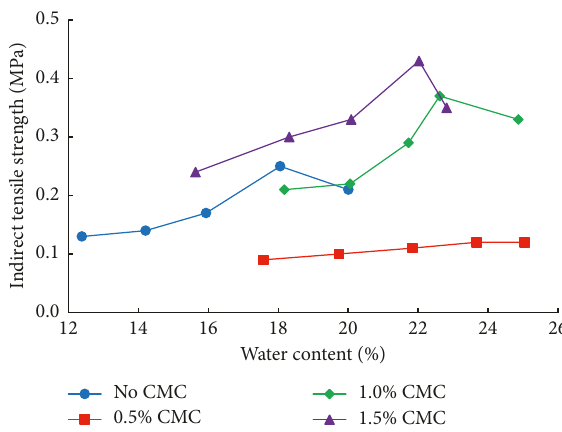
Figure 8: Moisture-indirect tensile strength relation for CMC-stabilized soil.